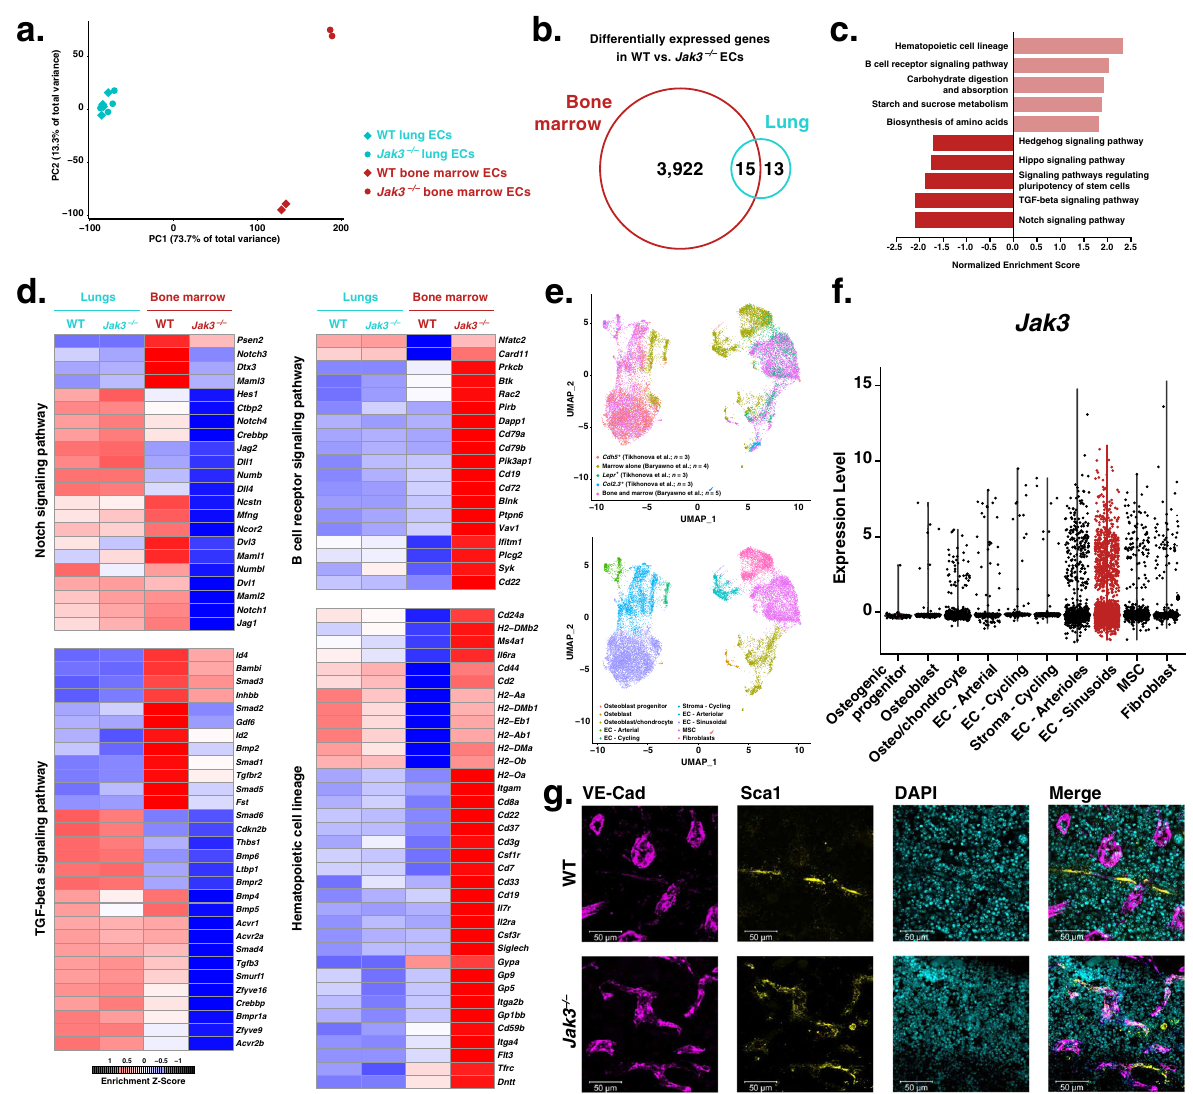
Fig. 2 Loss of Jak3 alters angiocrine program and canonical endothelial cell (EC) protein expression pattern in the bone marrow. a Principal component analysis showing principal component 1 (PC1) plotted against PC2 using RNA sequencing (RNA-seq) counts from wild-type (WT) vs. Jak3 – / – lung (blue) and bone marrow (red) ECs ( n = 2 or 3 per group). b Venn diagram displaying number of intersecting overrepresented gene transcripts that resulted from differential expression analyses of WT and Jak3 – / – bone marrow and lung ECs (FDR < 0.05). c Bar plot of enrichment scores of the 10 most dysregulated Kyoto Encyclopedia of Genes and Genomes (KEGG) 54 – 56 terms generated by gene set enrichment analysis (GSEA) using the log 2 fold change of the differentially expressed gene transcripts in Jak3 – / – bone marrow ECs compared to their WT counterparts. d Heatmaps depicting normalized transcript abundances of genes that contributed to the 2 most upregulated and the 2 most downregulated KEGG terms by GSEA ( n = 2 or 3 per organ). e Uniform Manifold Approximation and Projection (UMAP) obtained by single-cell RNA sequencing (scRNA-seq) of bone marrow cells. Raw scRNA-seq counts were obtained from Tikhonova et al. 62 (GEO: GSE108892) and Baryawno et al. 74 (GEO: GSE128423), combined, and re-analyzed for this publication. Data are shown clustered by provenance (top) and tissue type (bottom). MSC: mesenchymal stem cells. f Violin plot illustrating Jak3 transcript abundance as obtained from combined scRNA-seq analysis of bone marrow cells from Tikhonova et al. 62 (GEO: GSE108892) and Baryawno et al. 74 (GEO: GSE128423). Each dot represents one cell; the cluster identi fi ed as sinusoidal endothelial is highlighted in red. g Representative anti-VE-Cad (magenta), anti-Sca1 (yellow), and DAPI (cyan) immuno fl uorescent staining of WT (top) and Jak3 – / – (bottom) femurs ( n = 3). Scale bar is 50 μ